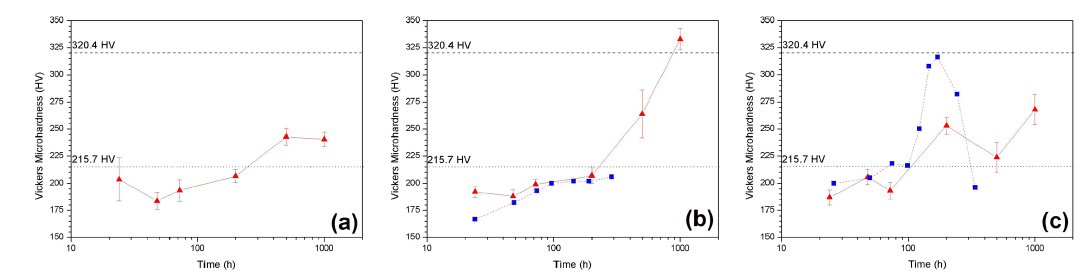
Figure 4. Vickers microhardness values of Inconel 625 superalloy as function of aging time at (a) 550, (b) 625, and (c) 725 °C. The triangles are the values found in the present work while the squares are from Shaikh et al. 14